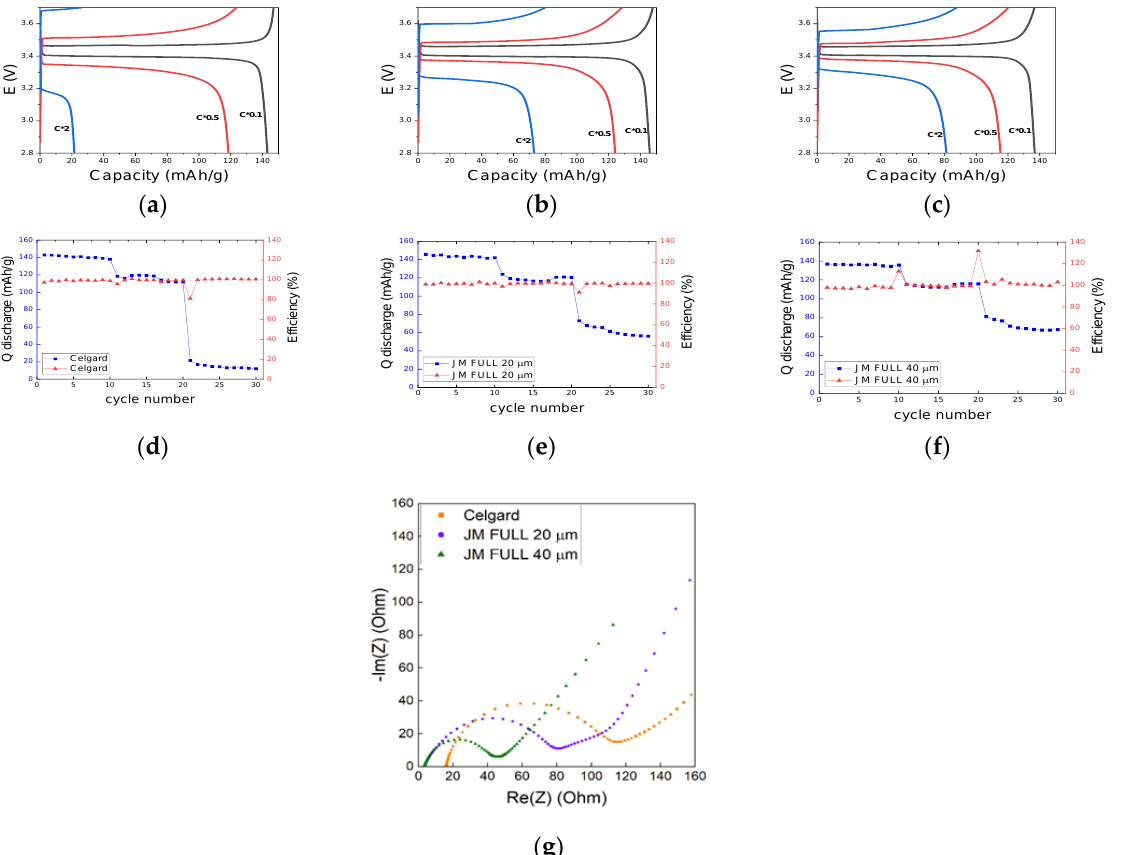
Figure 4. ( a – f ) Charge/discharge GCPL experiments performed at C/10, C/2, and 2C on the Li/sepa- rator/LFP full cell: ( a , d ) Celgard TM , ( b , e ) FULL 20, and ( c , f ) FULL 40 JMs. ( d – f ) Blue and red symbols represent the discharge specific capacity and Coulombic efficiency, respectively; ( g ) EIS spectra of the investigated membranes.